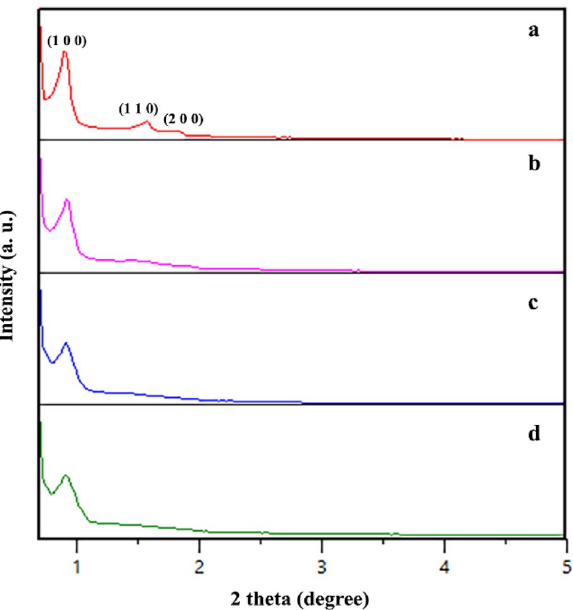
Figure 8. Low-angle XRD patterns of ( a ) SBA-15, ( b ) SBA-15/Fe 3 O 4 , ( c ) APTES@SBA-15/Fe3O4, and ( d ) the guanidinylated SBA-15/Fe